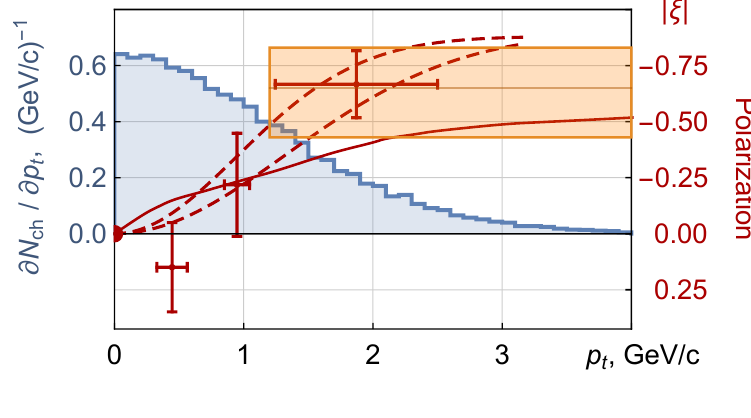
Figure 2 . Polarization of (cid:3) + as a function of its transverse momentum. Experimental data: red c crosses [45], orange rectangular area [44]; dashed red curves | experimental data (cid:12)t by the normal distribution; solid red curve | theoretical prediction by the so-called hybrid model [48] for the process (cid:25) (cid:0) p ! (cid:3) + X . Channeled baryons distribution over transverse momentum: blue histogram c (simulation results obtained using